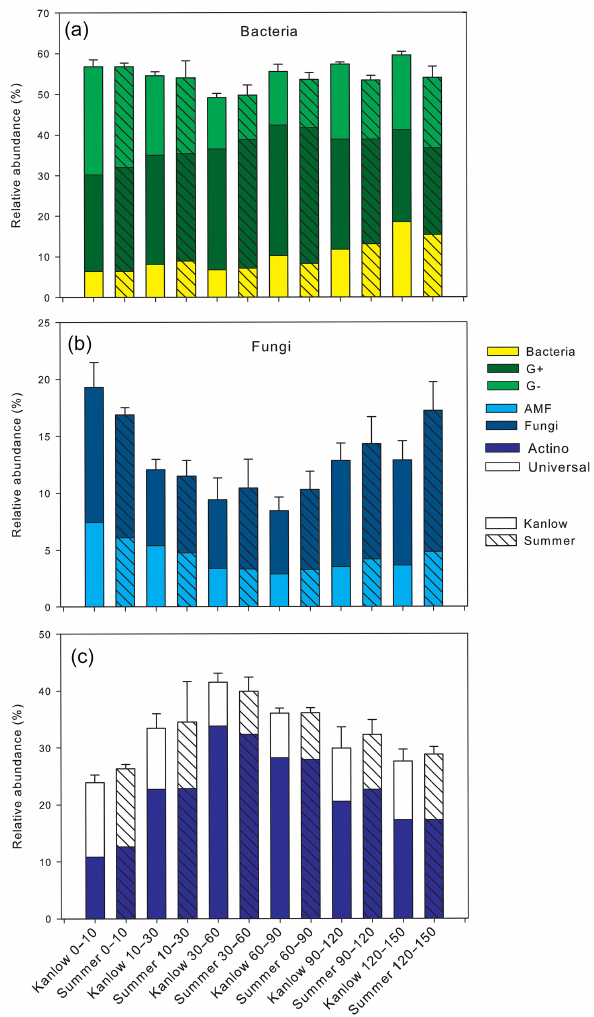
Figure 2. Soil microbial community composition (relative abun- dance, mol%) for switchgrass ecotypes Kanlow and Summer from 0 to 150cm for (a) bacterial groups, (b) fungal groups, and (c) acti- nomycetes and universal microbial groups. Error bars represent standard deviations ( n = 3).